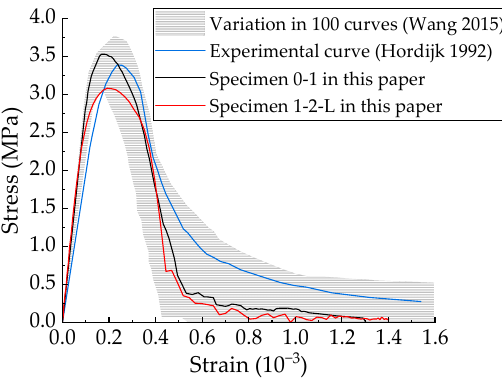
Figure 5. Comparison of stress-strain curves in uniaxial tension